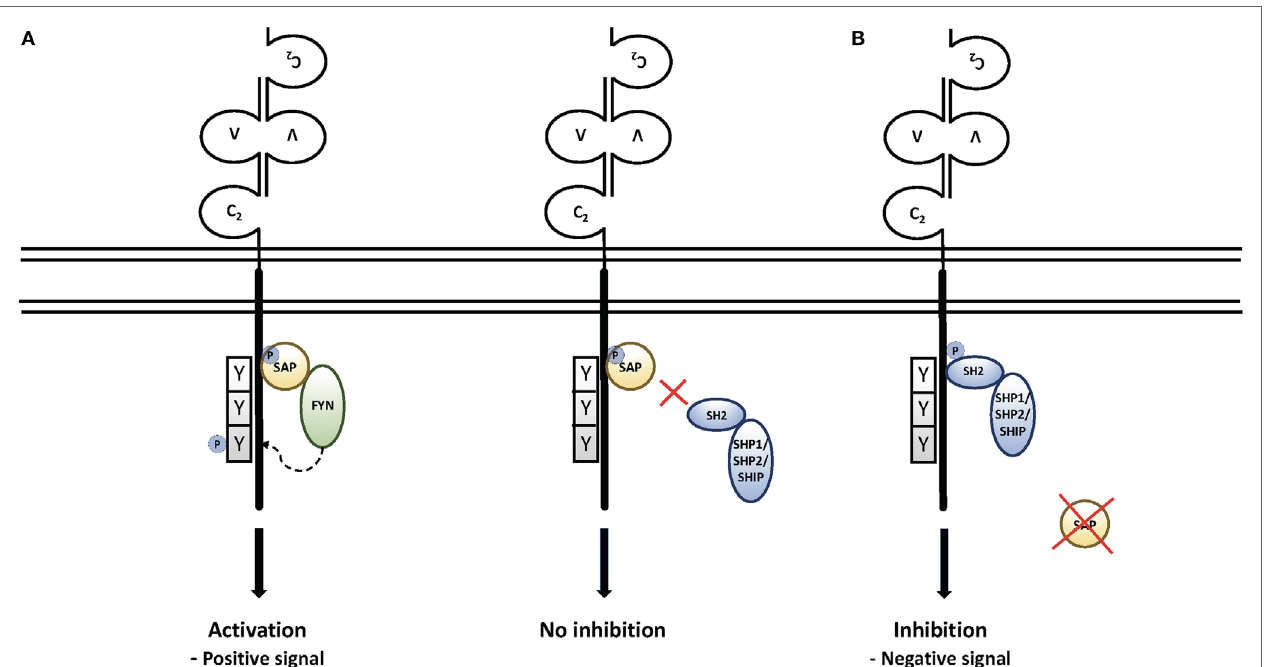
FiGURe 1 | Signaling through the signaling lymphocyte activation molecule (SLAM) family receptors: (A) upon engagement, SLAM family members recruit the SAP SH2 domain to immunotyrosine switch (ITSM) motifs on their intracellular tails. This leads to the recruitment of Src family kinases, further phosphorylation of SLAM family receptors, and recruitment of downstream signaling molecules. Recruitment of SAP also prevents recruitment of the phosphatases SHP1, SHP2, and the lipid phosphatase SHIP (50). (B) In the absence of SAP, the engagement of SLAM family receptors leads to SH2-mediated recruitment of SHP1, SHP2, and SHIP, which are associated with strong inhibitory signals that affect T and NK cell function and cell death, as well as NKT cell